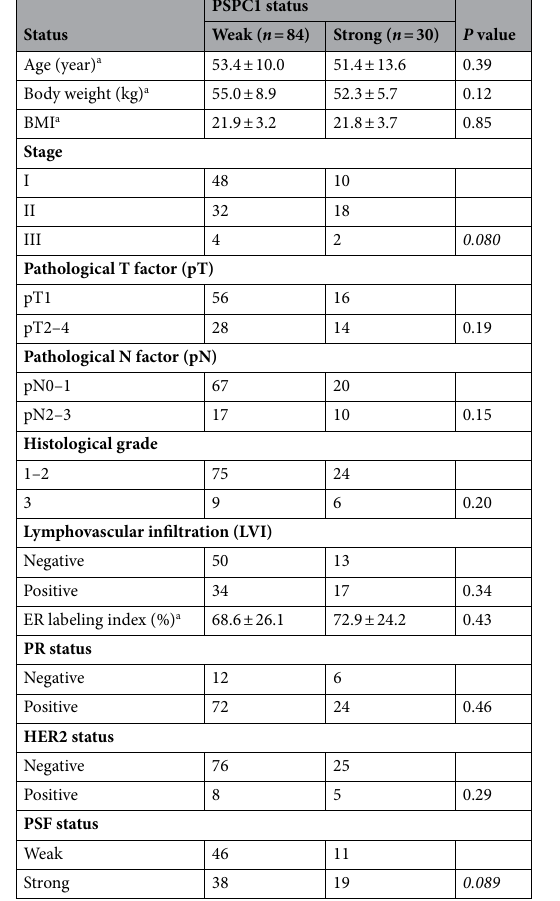
Table 1. Association between PSPC1 status and clinicopathological parameters in 114 breast cancer. 0.05 ≤ P value < 0.10 was considered borderline significant, and is listed in italics. a Data are presented as mean ± SD. All other values represent the number of